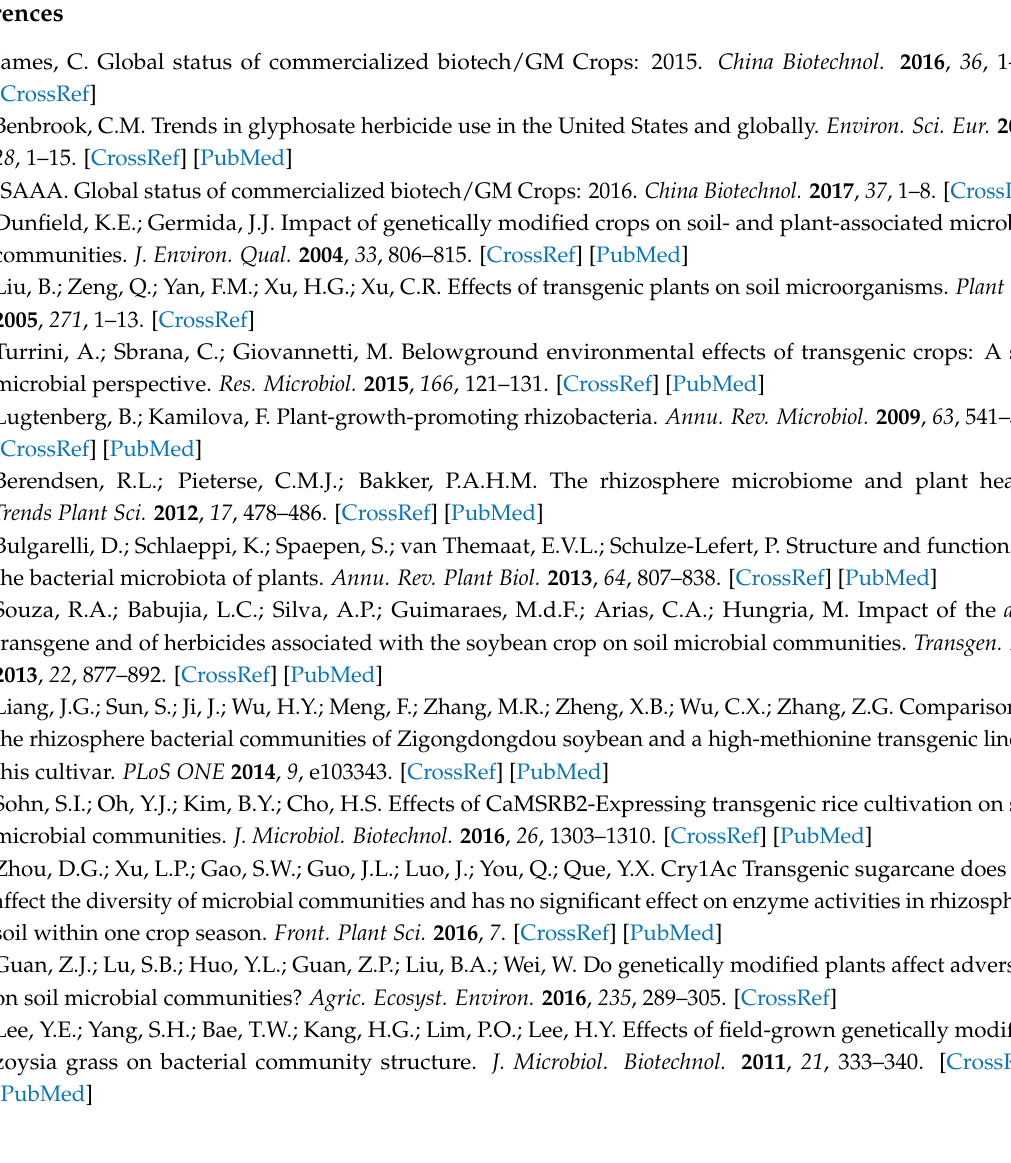
and comparison of mapped reads between MGMRh and MGNRh at the species level by One Codex based on One Codex DB, Table S16: Computation and comparison of mapped reads between MGMRh and MGNRh at the species level by One Codex based on RefSeq DB, Table S17: Comparison of mapped read count (%) of top 30 genera in the MGMRh and MGNRh samples by shotgun metagenomic